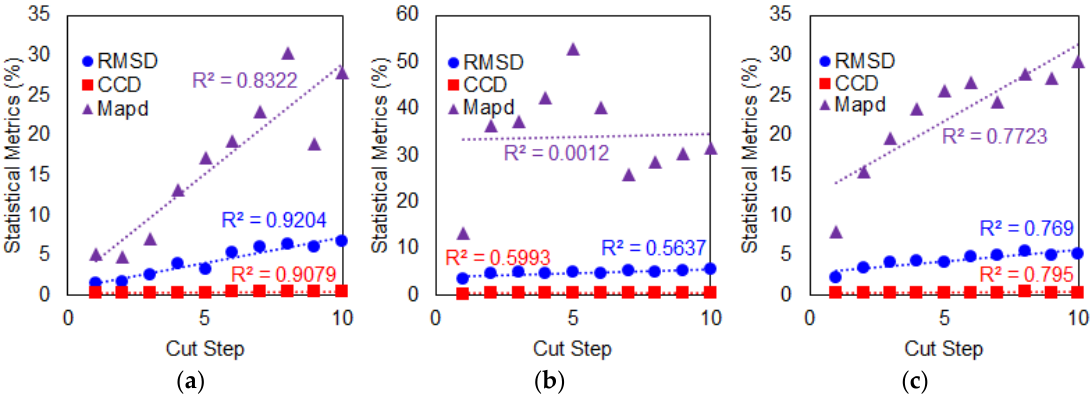
Figure 8. Performance evaluation of conventional PZT attachment method subject to damage ( a ) Case 1; ( b ) Case 2; ( c ) Case 3.